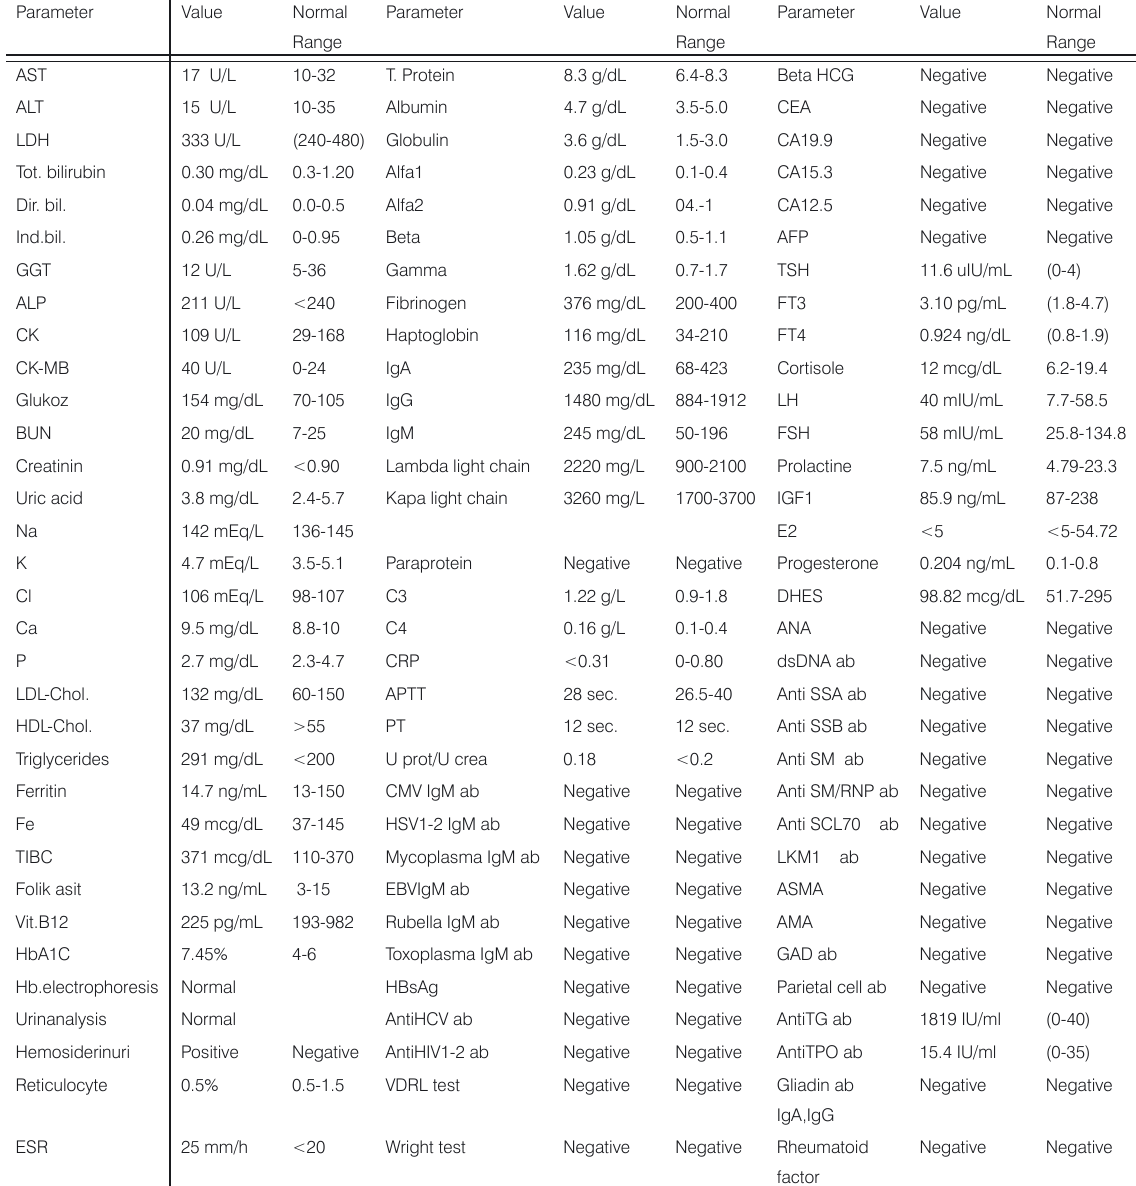
Table 1. Laboratory